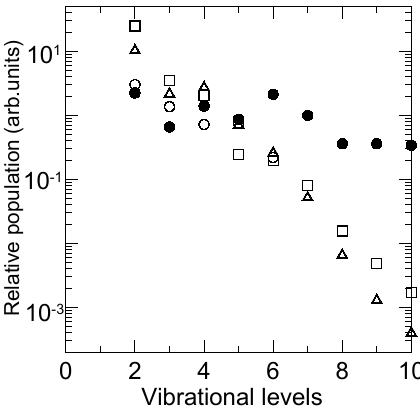
Fig. 3. The vibrational population of the B 3 5 g state: calculated from the A 3 6 + u distribution – triangles, from the W 3 1 u distibution Figure 3. The vibrational population of the B 3 Π g state: calculated from the A 3 Σ u+ distribution – – squares, experimental data by Ottinger et al. (1995) – solid and triangles, from the W 3 ∆ u one – squares, experimental data by Ottinger et al. (1995) – solid and open circles, for intramolecular and intermolecular electron energy open circles for intramolecular and intermolecular lelectron energy transfers, respectively. transfers,